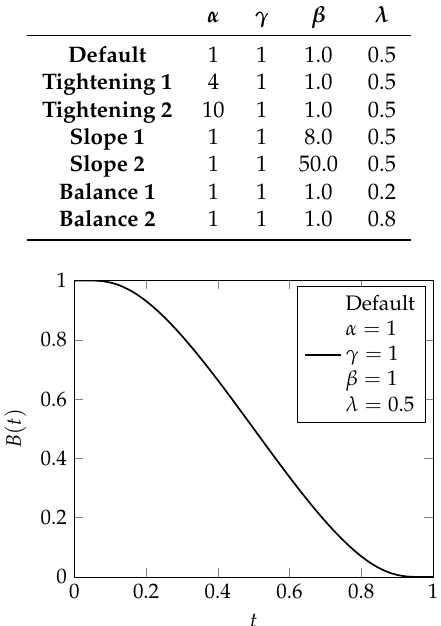
Table 2. Expo-rational blending function (ERB-function) parameter values used in the comparisons.